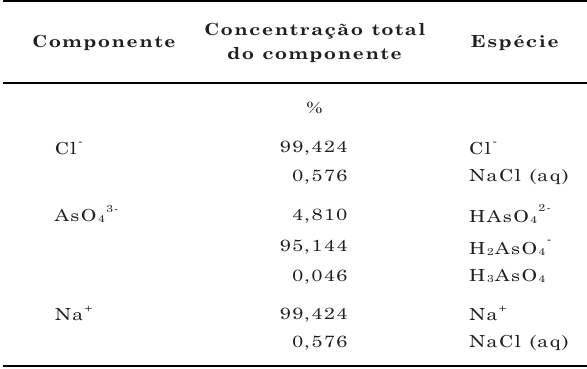
referência para solos não contaminados, pois representam o máximo do As disponível.